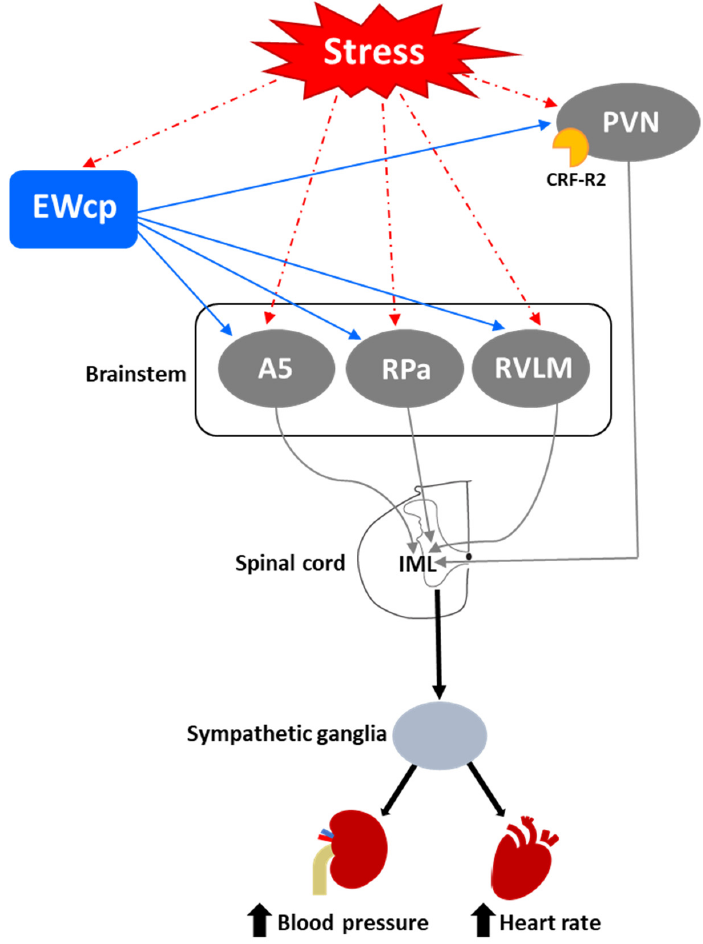
Figure 4. Connections of EWcp to presympathetic regions involved in stress-induced cardiovascular activity. Presympathetic neurons in brain areas involved in cardiovascular regulation, such as PVN, A5, RPa and RVLM, receive inputs from EWcp, which is also activated by stress. The medial parvocellular PVN, known to contain presympathetic neurons, shows a moderate density of CRF-R2. Stress-induced increase in sympathetic outflow to the kidneys and heart increases blood pressure and heart rate. For terms, see the list of abbreviations.